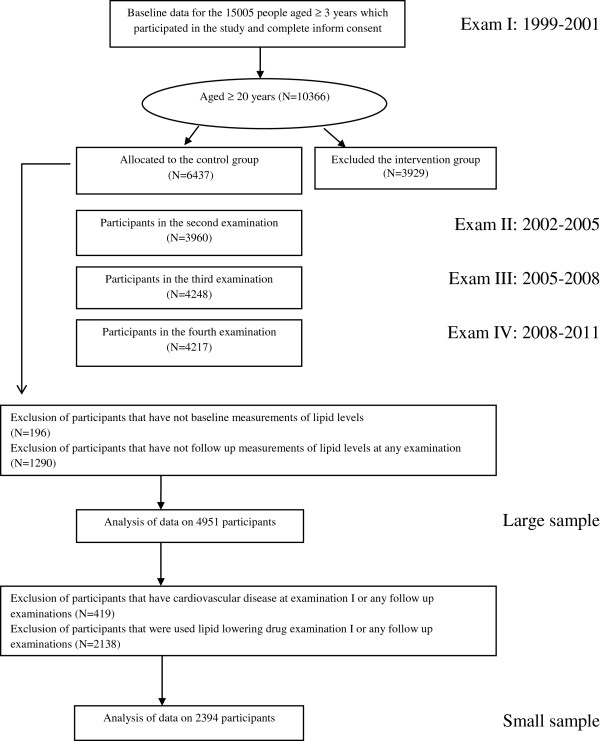
Outline of selection design of study participants.